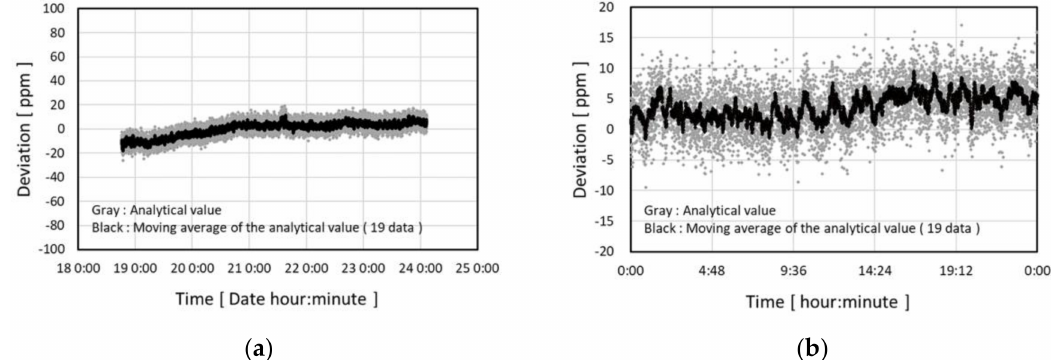
Figure 14. Estimation results of the long-term stability of the detection circuit: ( a ) 5 days; ( b ) 24